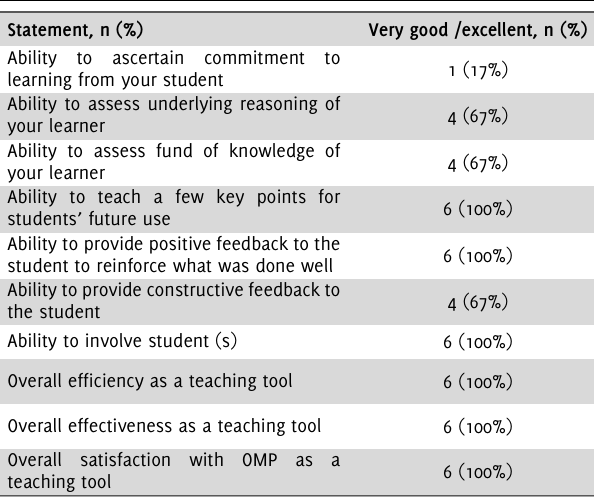
Table 3 . Usefulness of the OMP among those who completed the program (n=6)